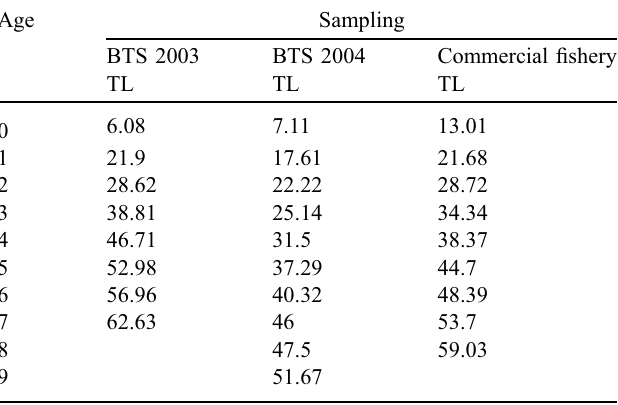
Table 3. Mean age-at-length of P. blennoides sampled by bottom trawl surveys (BTS) in 2003 and 2004 and from commercial fi sheries (TL: total length in cm) off Algeria.